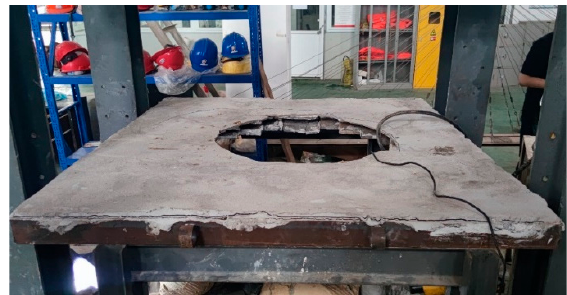
Figure 9. Brittle damage of specimen M1.